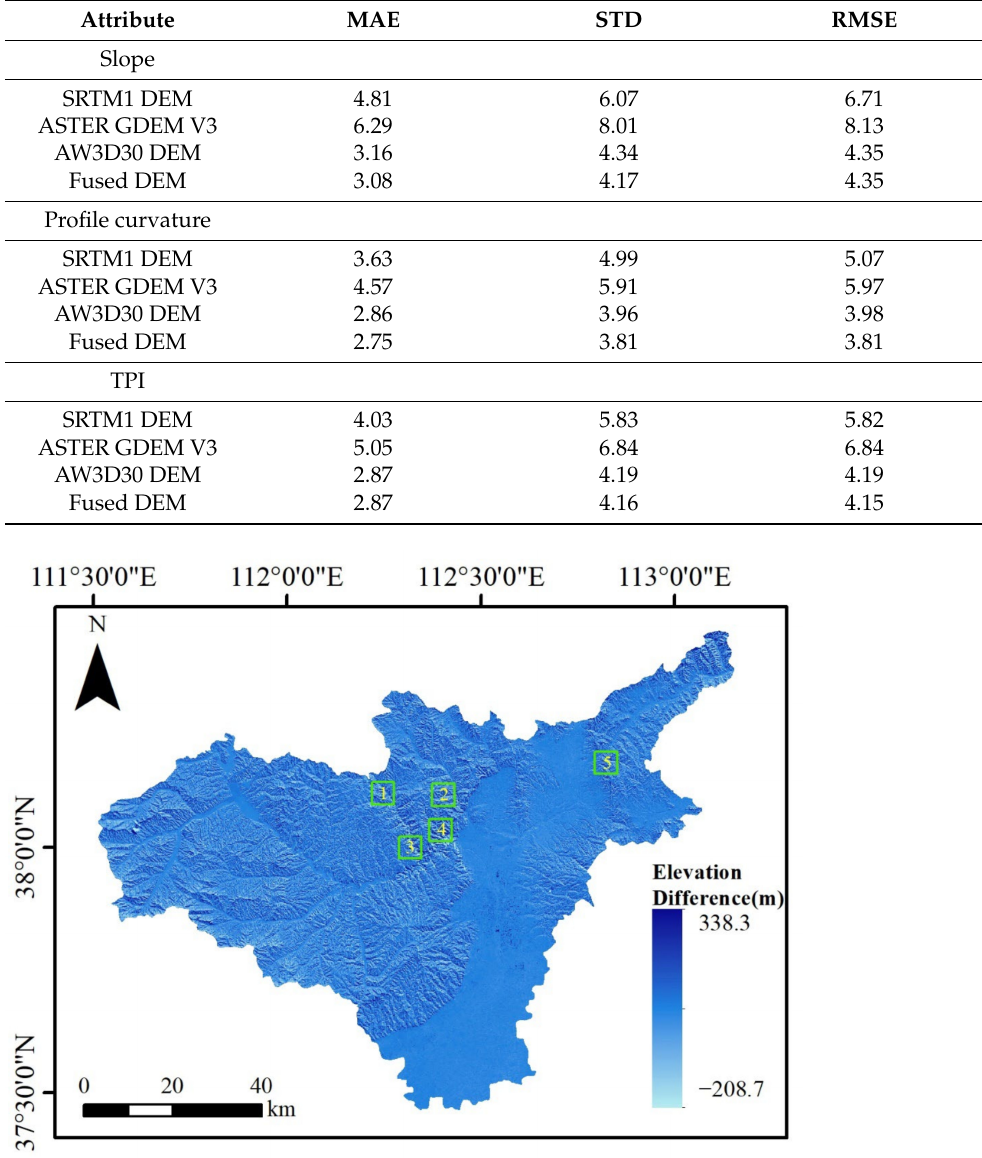
Figure 9. The elevation difference between the Fused DEM and reference